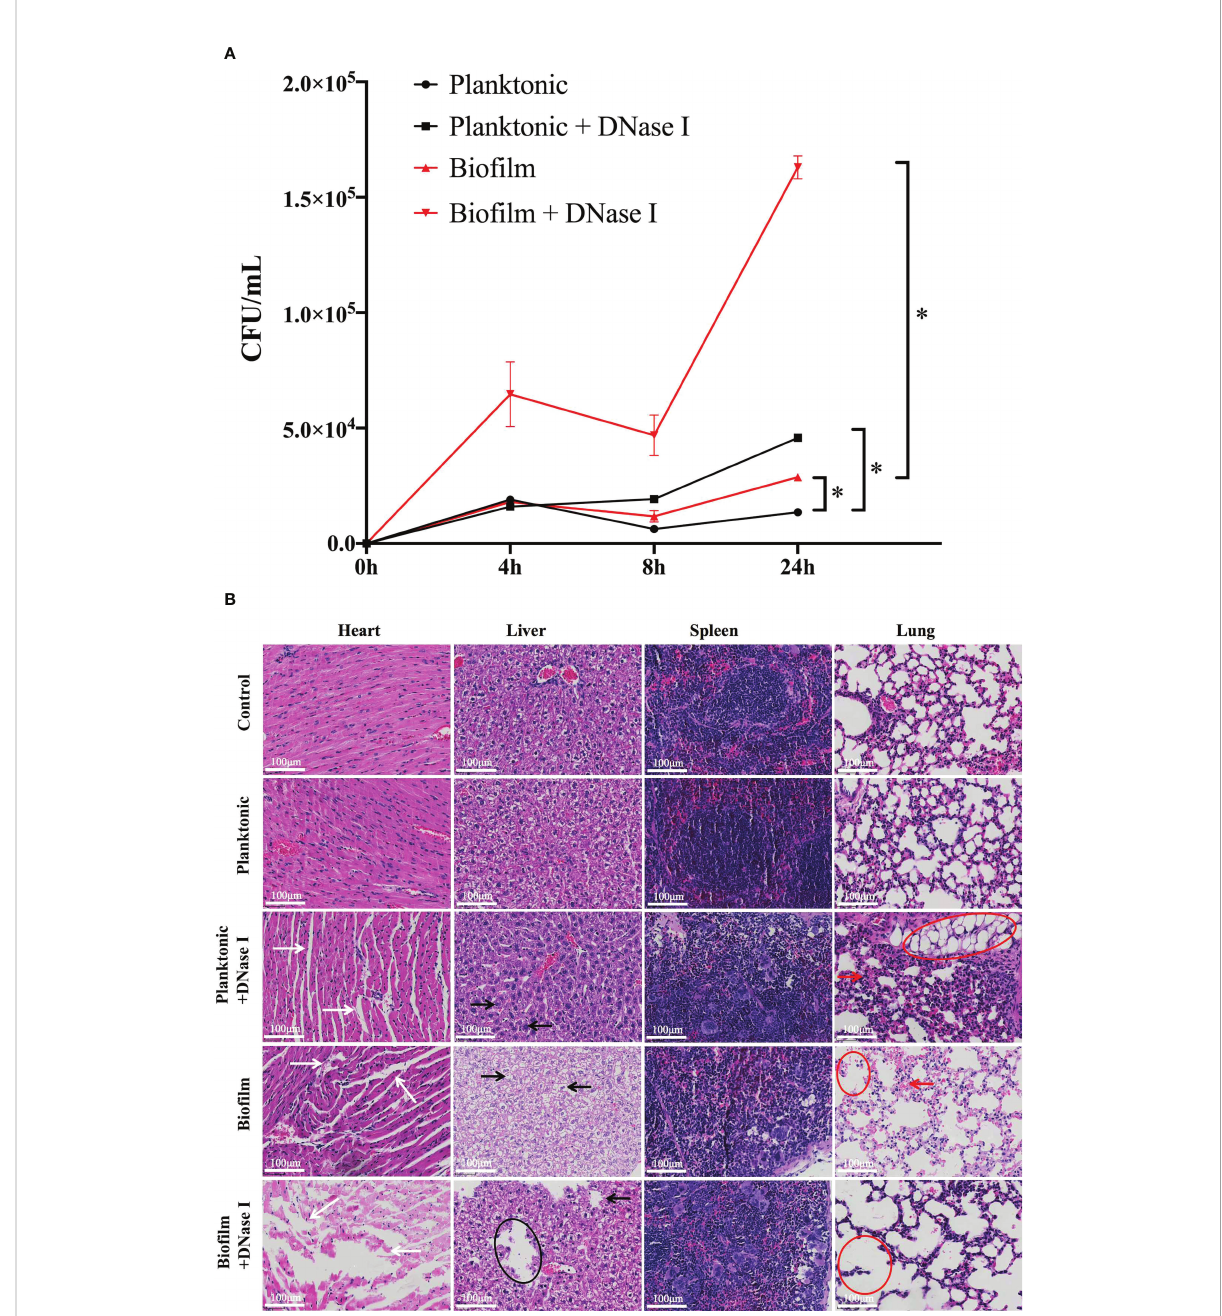
FIGURE 6 In vivo reaction of neutrophils challenged with different states of S. mutans . (A) A comparison of bacterial burden isolated from the mice blood post-infection between planktonic and bio fi lm S. mutans was shown. At 8 h and 24 h post-infection, more viable bio fi lm cells than planktonic cells could be detected. When DNase I was added to degrade NETs DNA, the bacterial cells in both challenge groups all displayed enhanced survival in blood, especially the bio fi lm cells. Comparison between planktonic and bio fi lm S. mutans with and without DNase I treatment was performed at each time point. The results were depicted as mean ± SD (n=5). Statistical analysis was performed using a one-way ANOVA following Bonferroni multiple comparisons post-hoc test with p <0.05. *p<0.05 (B) 6 – 7 weeks old Balb/C mice were infected with 1.5 × 10 8 cells/mL of planktonic or bio fi lm S. mutans or were mock-infected with PBS. DNase I was applied with S. mutans simultaneously and 12h post- infection. Five mice were enrolled per treatment group. 24h after infection, the mice were euthanized and the histopathological characteristics were evaluated. Representative histopathological appearance of the heart, liver, spleen, and lung tissue following hematoxylin-eosin (H&E) staining in each group. The white arrows indicated a wide myocardial gap and blurred myo fi lament boundary in heart tissue. The black arrows and circles showed swollen liver cells with hepatic lipid droplets formation and steatosis. The red arrows and circles demonstrated abnormal structures of the lung alveoli with thickening alveolar walls and accumulation of alveolar vacuolation in lung specimen. (scale bar: 100 m